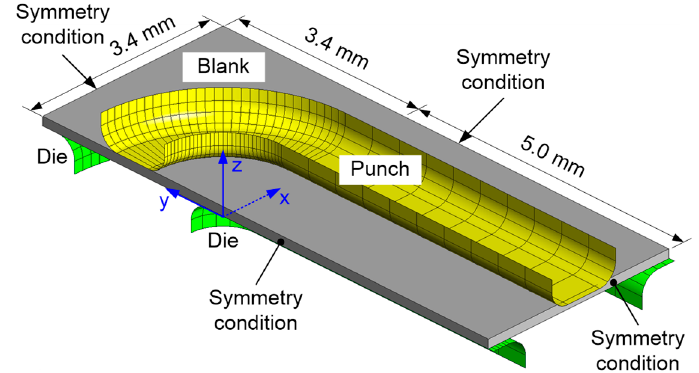
Figure 18. Finite element model adopted to simulate the stamping of the U-bend channel section (revolved tool geometry with a straight section).